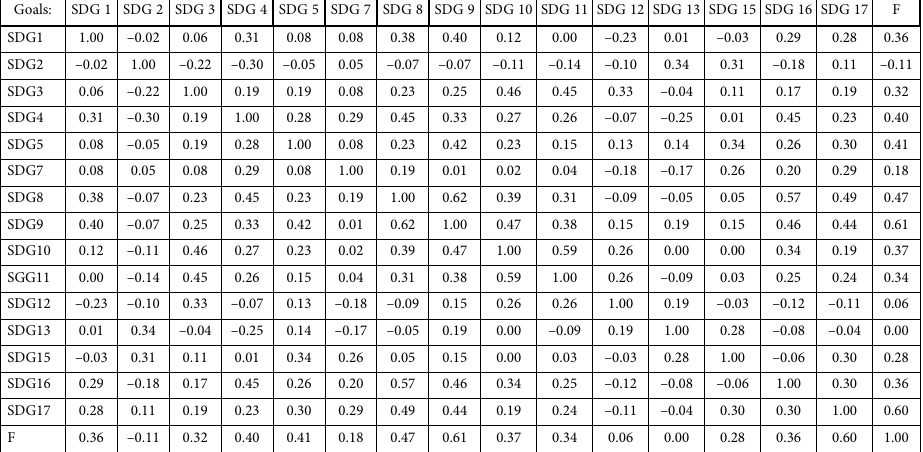
Table 3. Kendall τ correlation coefficient in the scope of sustainable finance and the selected goals of Agenda 2030 in 2016